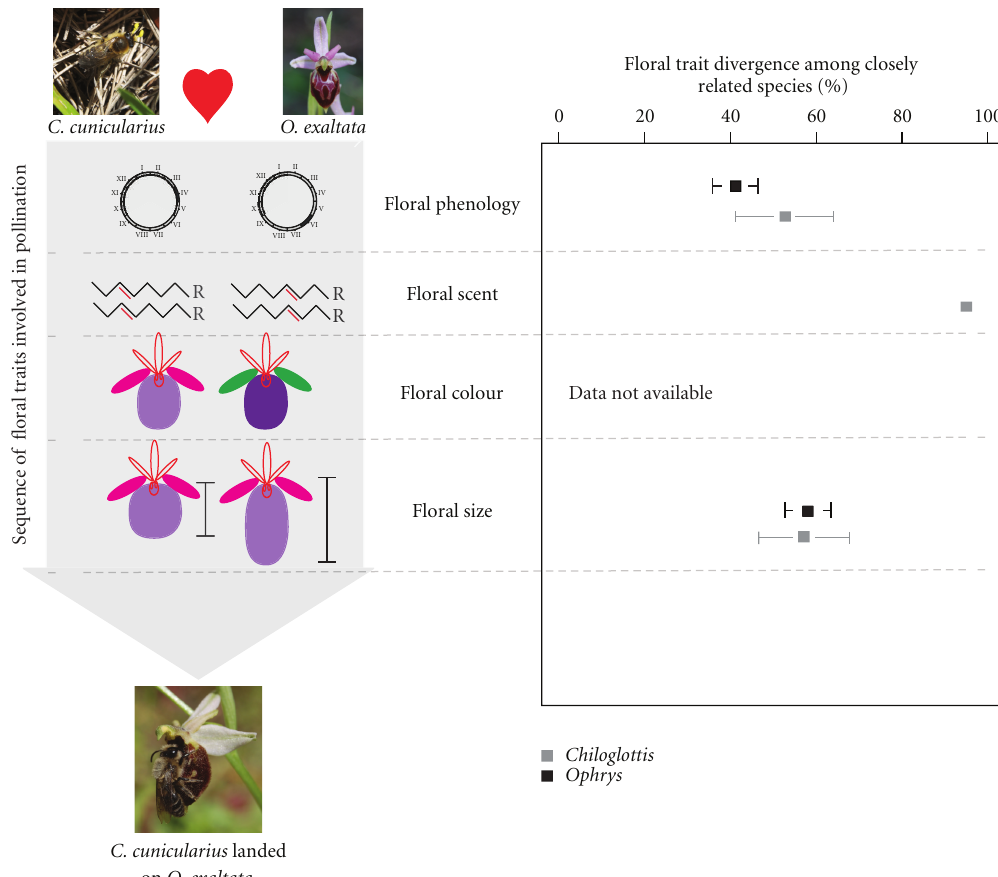
Figure 1: Summary of floral traits involved in plant-pollinator interaction. The left flow-chart shows the sequence of floral traits involved in pollination, whereas the right side shows the divergence of these traits between closely related species pairs in sexually deceptive orchids. Dark squares refer to Ophrys ; grey squares to Chiloglottis . Floral trait data were extracted from Table 1 and Table S1; error bars represent standard error.